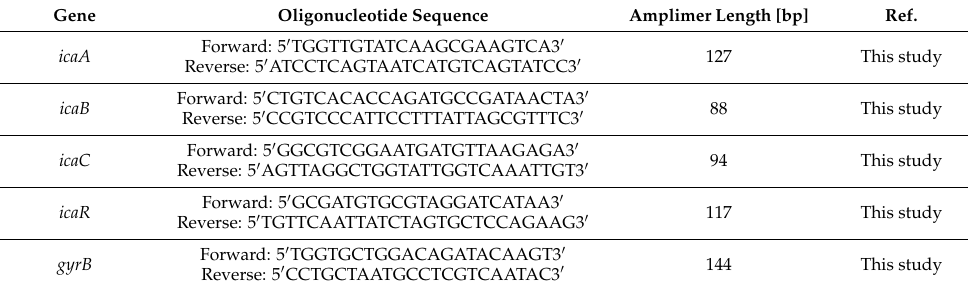
Table 1. Sequences of primers used in the RT-qPCR